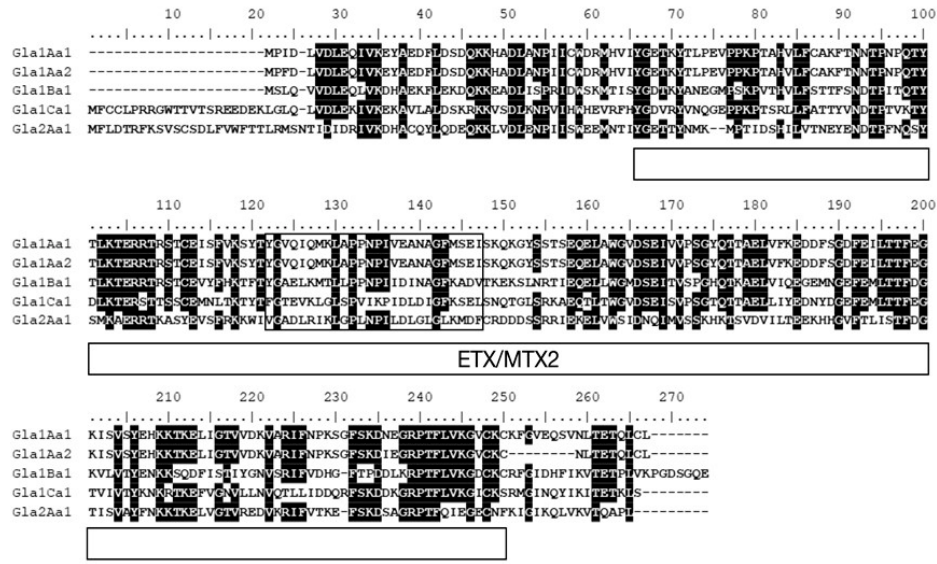
Figure 2. Multiple sequence alignment of Glabralysin proteins. The deduced amino acid sequences of Glabralysins were aligned using Clustal Omega program. Residues conserved in at least 80% of the aligned sequences are highlighted in black. The predicted ETX-MTX2 domain is indicated by an over lined box. The putative transmembrane domain (TMD), boxed in black, was identified using the PRED-TMBB server (prediction of transmembrane beta barrels’ proteins).